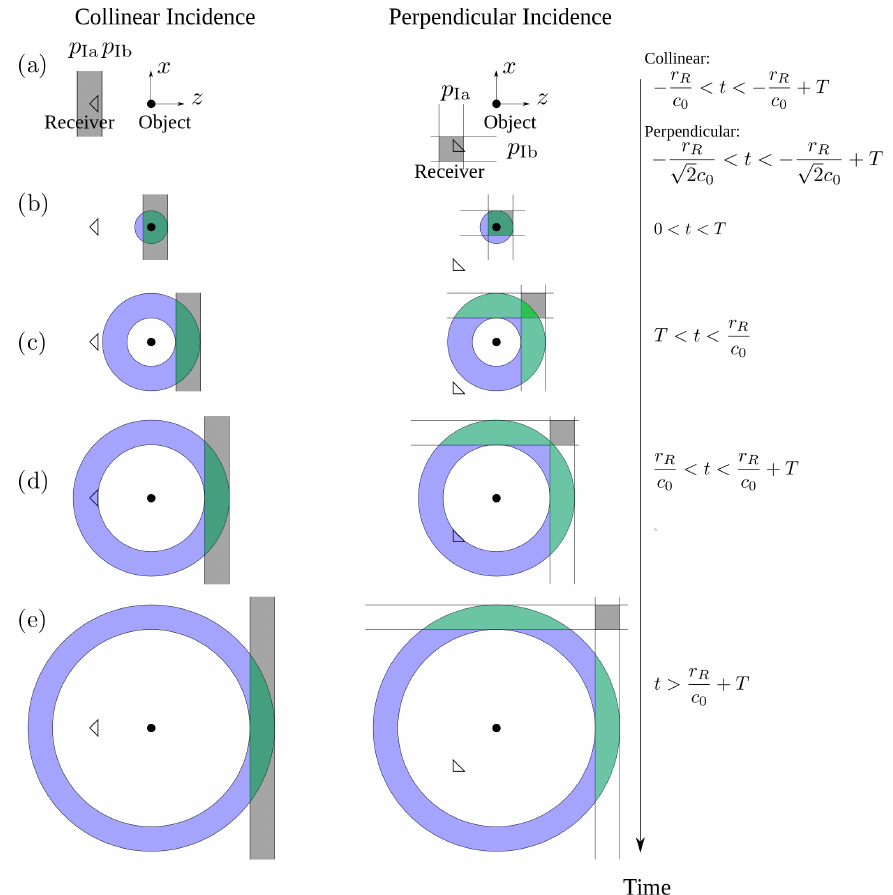
Figure E2. Primary incident and scattered waves of compact support and regions of compact support overlap, at different time instances ( a – e ). The left column is for the collinear incidence case, and the right column is for the perpendicular incidence case. The overlap regions for the incident waves, scattered waves, and incident and scattered wave are volumes in 3-D, and they are projected and shown on a 2-D plane as the gray, blue and green areas,